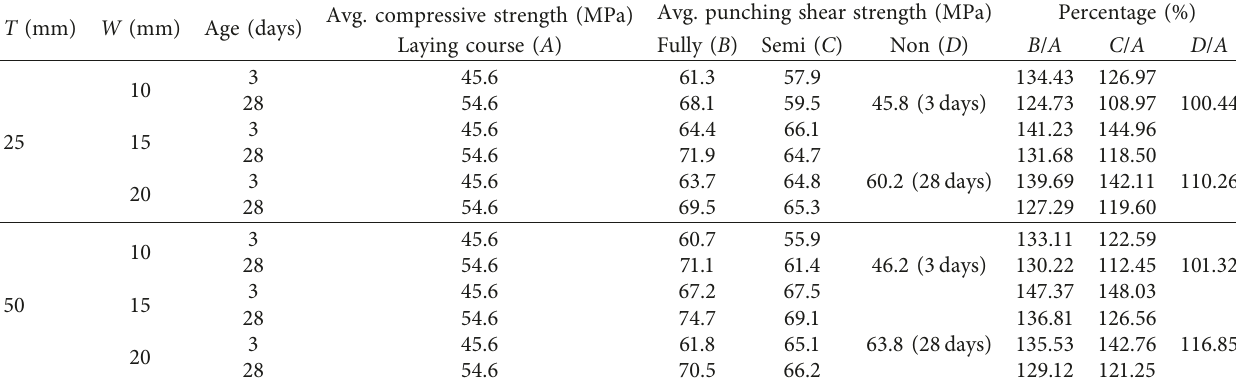
Table 8: Mortar strength outcome and